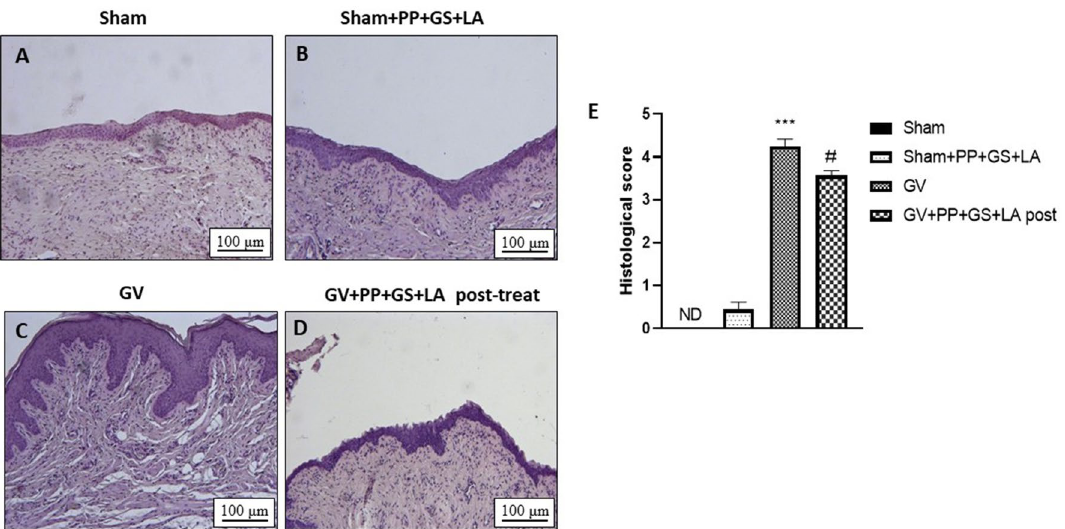
Figure 3. Effect of the product containing PP, GS, and LA on histological damage in post-treatment condition. The treatment with the product containing PP, GS and LA ( D ) was able to reduce histological damage post GV infection ( C ). No significance difference was observed in the sham group treated with PP, GS and LA ( B ) compared to sham group alone ( A ). ( E ) *** p < 0.001 vs Sham; # p < 0.05 vs GV